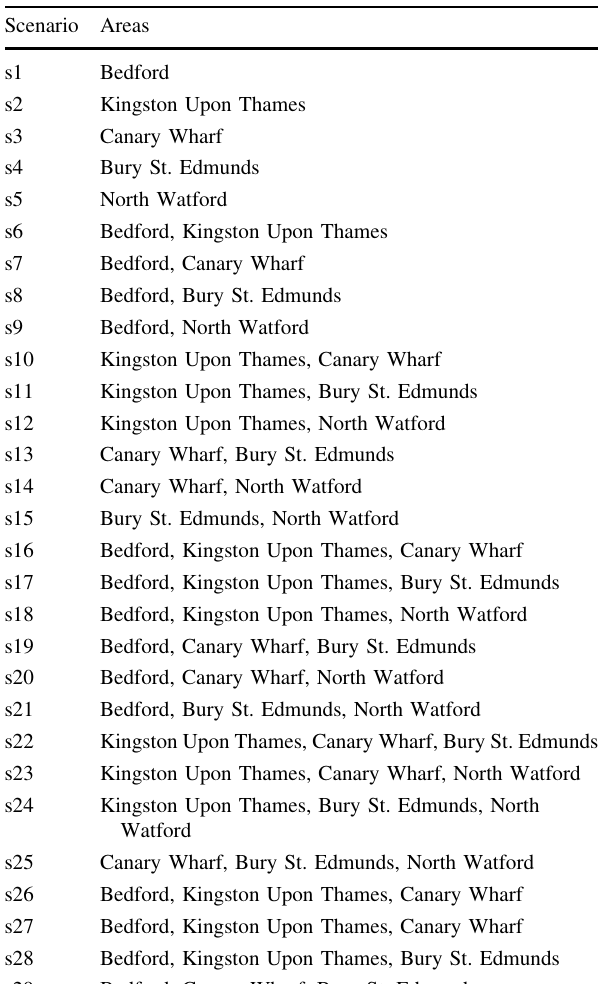
Table 3 Overview of 31 unique failure combinations for five flood- impacted electrical substations in the southeast of England Scenario